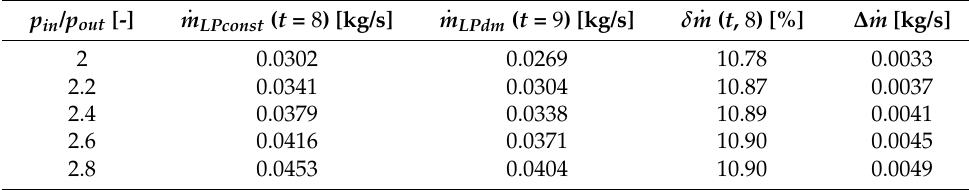
Table 5. Change of the leakage rate by Equation (17) depending on the pressure ratio p in /p out for the initial 8t and the designed geometry 9t of the staggered seal, RC = 0. 542 mm, T in = 300 K, p out = 10 5 Pa.